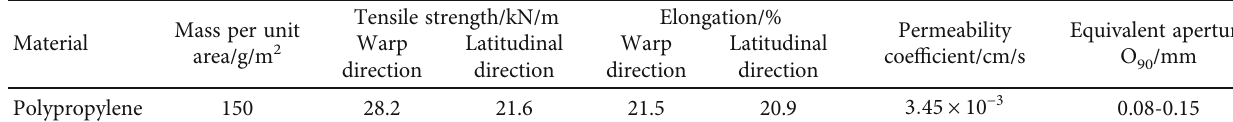
Table 1: Main parameters of the soilbag materials.